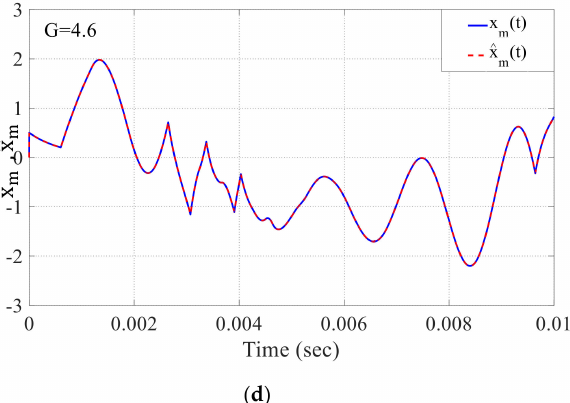
Figure 12. Impact of the loop gain on the recovered signal ˆ x m ( t ) in the PLL ( a ) G = 1, ( b ) G = 3, ( c ) G = 4, ( d ) G = 4.6.